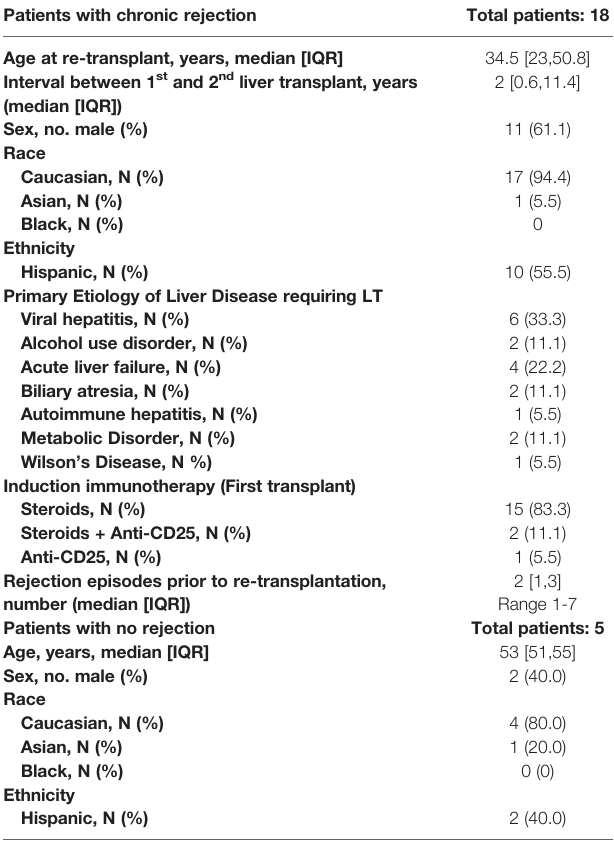
TABLE 1 | Patient characteristics. Patients with chronic rejection Total patients: